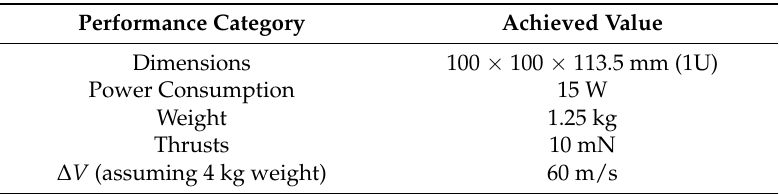
Table 10. Busek Ammonia Micro-Resistojet Performance